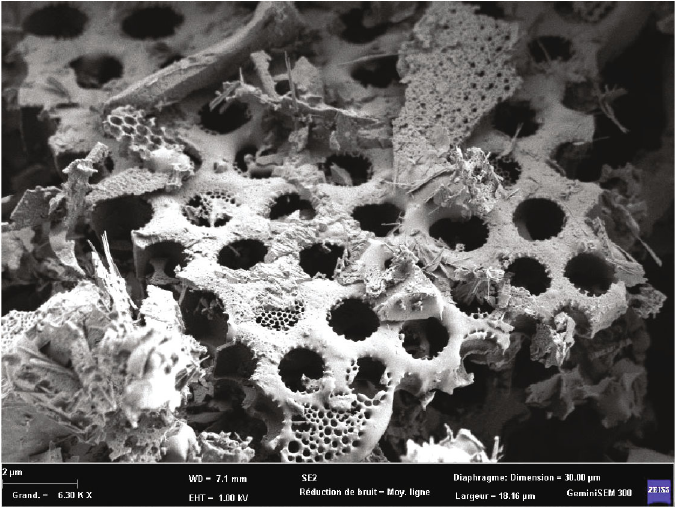
Figure 2: SEM images of ND displaying surface morphology